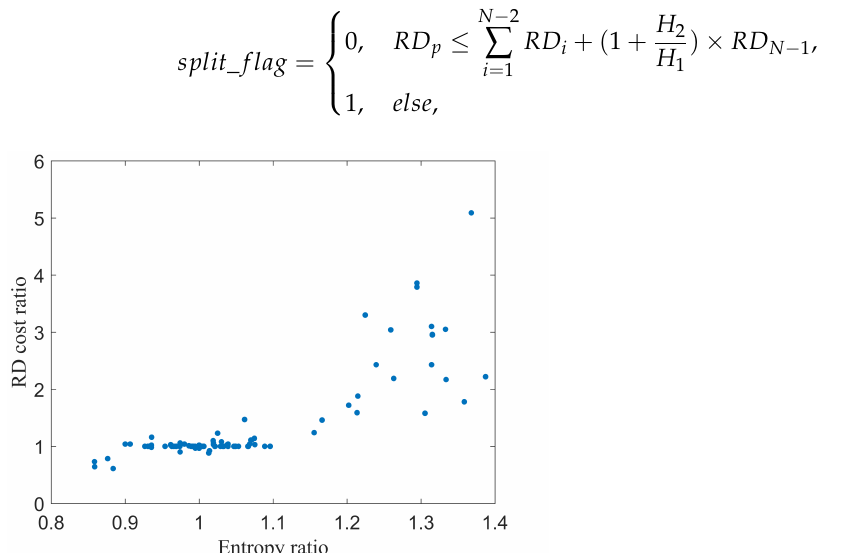
Figure 1. The relationship between RD cost ratio and entropy ratio of adjacent sub-CUs under binary